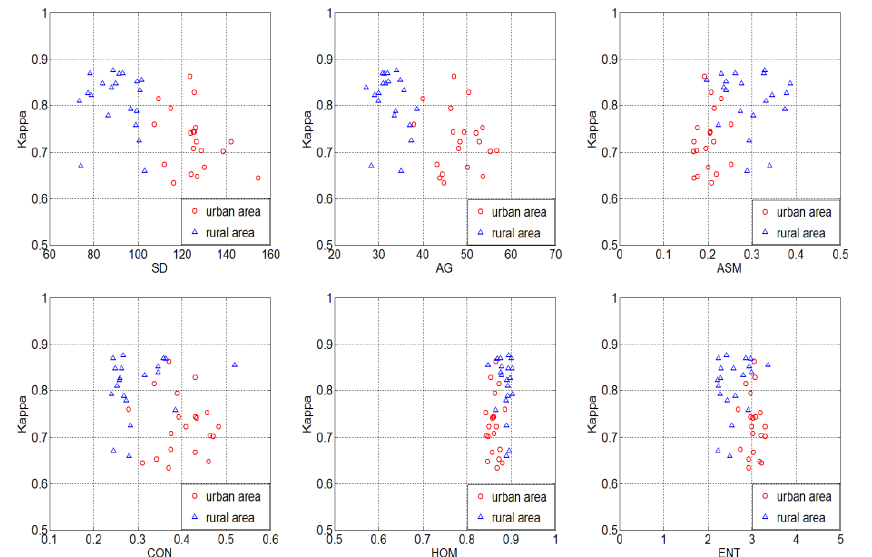
Figure 3. The relationship of the quality index and classification accuracy in different